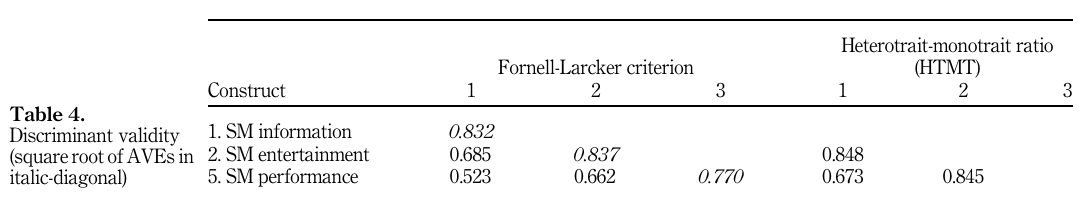
Table 3. Reliability and convergent validity